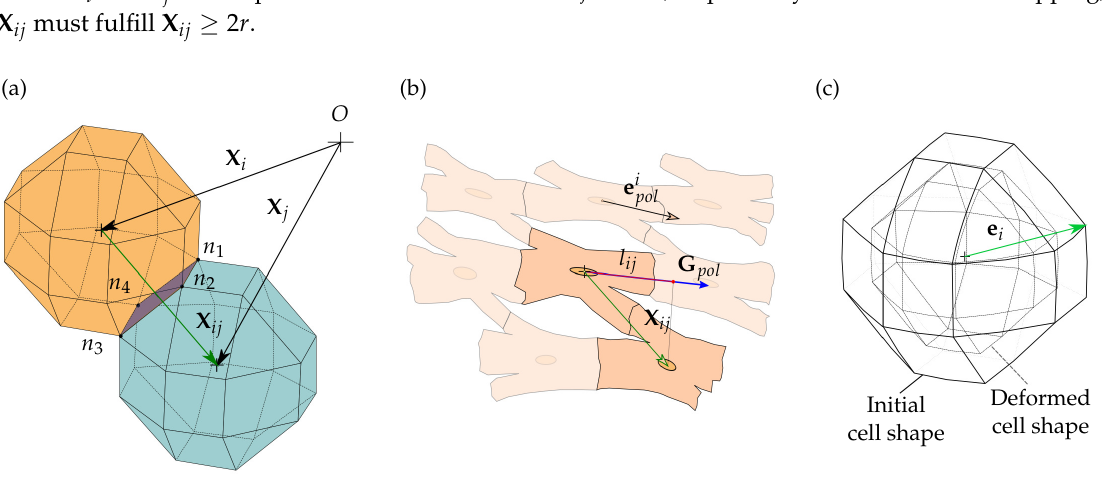
Figure 3. Cell interaction. ( a ) X i and X j are the coordinate vectors of the i th and j th cells, respectively, and X ij is the contact vector, which satisfies (cid:107) X ij (cid:107) ≥ 2 r . The contact face, defined by the nodes ( n 1 : n 4 ) loses the capacity to interact with the ECM. ( b ) The global polarization direction G pol , is defined through the cell polarization e i . The projection of the cell contact, l ij , is defined by the projection pol of the contact vector, X ij , in the G pol direction. Being the cell junction possible when l ij ≥ l adh , and (cid:107) X ij (cid:107) = 2 r . ( c ) The direction of the internal cell deformation, e i , is considered to establish the direction of the cell mechanical